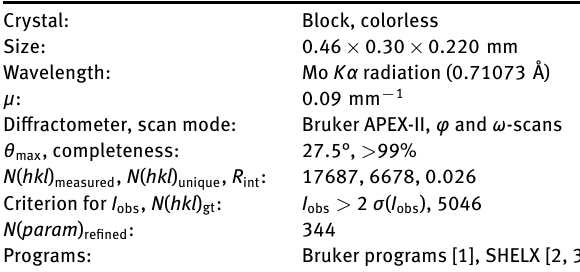
Table 1: Data collection and handling.